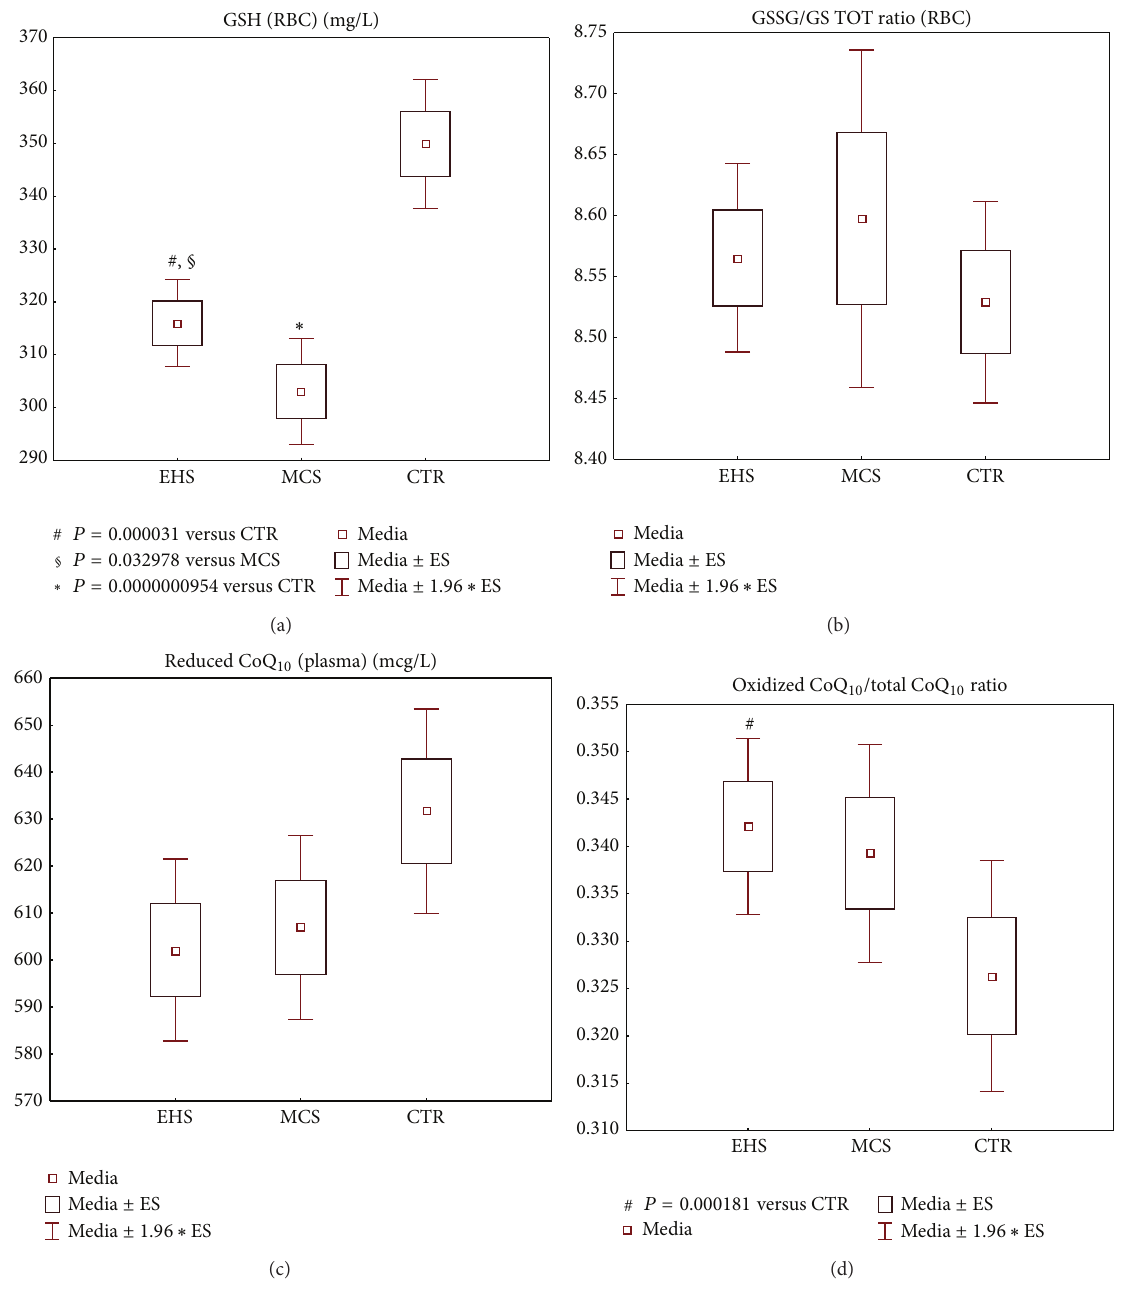
Figure 6: Metabolic redox parameters: levels of the low-molecular weight antioxidants/cofactors, erythrocyte glutathione ((a) and (b)), and plasma coenzyme Q 10 ((c) and (d)), in the groups of patients self-reporting electromagnetic hypersensitivity (EHS, 𝑛 = 153 ), of patients affected by multiple chemical sensitivity without EHS symptoms (MCS, 𝑛 = 147 ), and of control healthy subjects (CTR, 𝑛 = 132 ). Values are represented as mean ( ◻ ), standard error of the mean (upper and lower limits of the box), and 1.96 × standard error (upper and lower whiskers). Intergroup significant differences ( P ) are reported under each panel. RBC: red blood cells: GSH: glutathione reduced form; GSSG: glutathione oxidized form; GS TOT: total glutathione; CoQ 10 : coenzyme Q 10 .